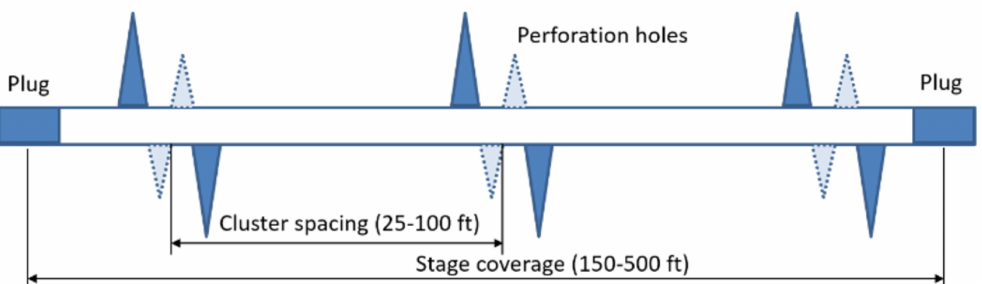
Figure 1. Sketch of a 3-cluster hydraulic fracturing